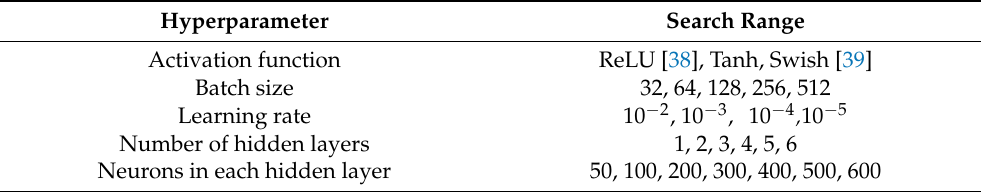
Table 4. Hyperparameters’ space for TPE.